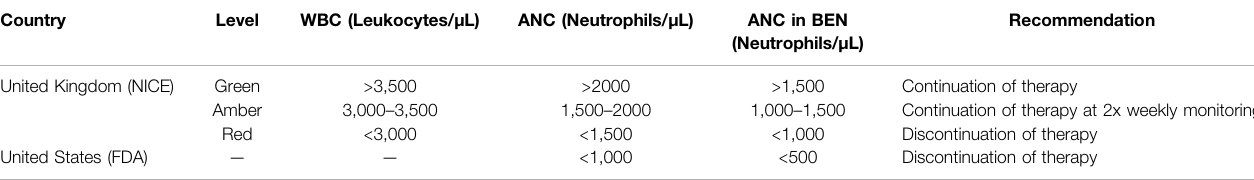
TABLE 3 | Monitoring criteria for clozapine therapy in the United Kingdom and the United States; modi fi ed according to (Mijovic and MacCabe, 2020).